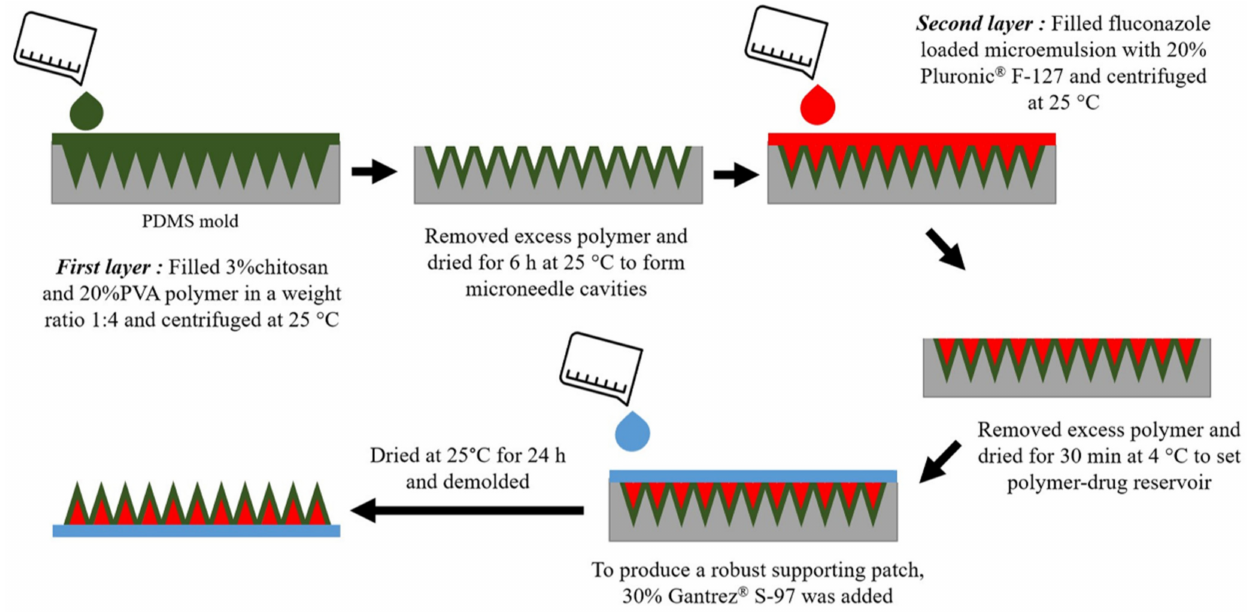
Figure 1. Schematic diagram of fabrication of FLUZ-MEs-loaded two-layered dissolving MNs. For the control MNs formulation, FLUZ-suspension-loaded MNs were fabricated. A 1.27% w / w of FLUZ suspension was loaded into a polymer mixture of 3% w / w chitosan and 20% w / w PVA (1:4 weight ratio). This mixture was cast into PDMS micromolds and centrifuged at 4000 rpm, 25 ◦ C, for 30 min. The control MNs were dried at 25 ◦ C for 24 h and gently peeled out of the PDMS